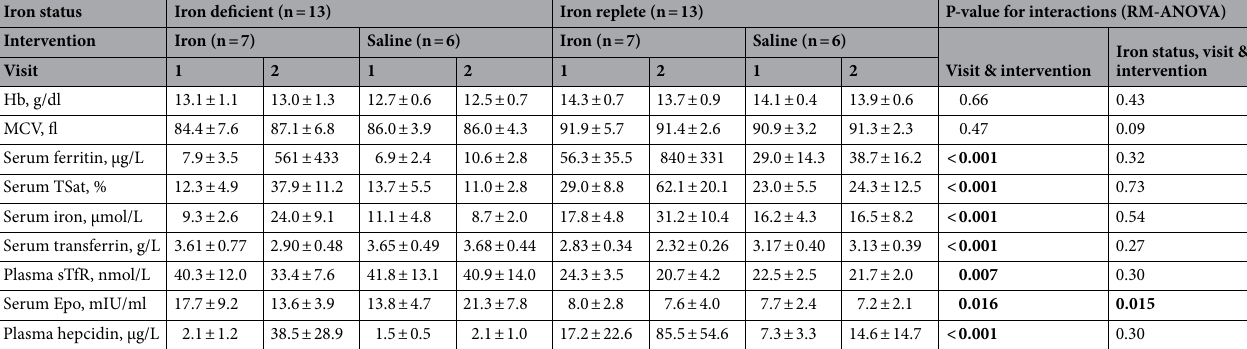
Table 2. Haematological and iron parameters over the course of the study. Values are means ± SD. Statistically significant P-values appear in bold. RM-ANOVA, repeated measures analysis of variance; MCV, mean cell volume; TSat, transferrin saturation; sTfR, soluble transferrin receptor; Epo,